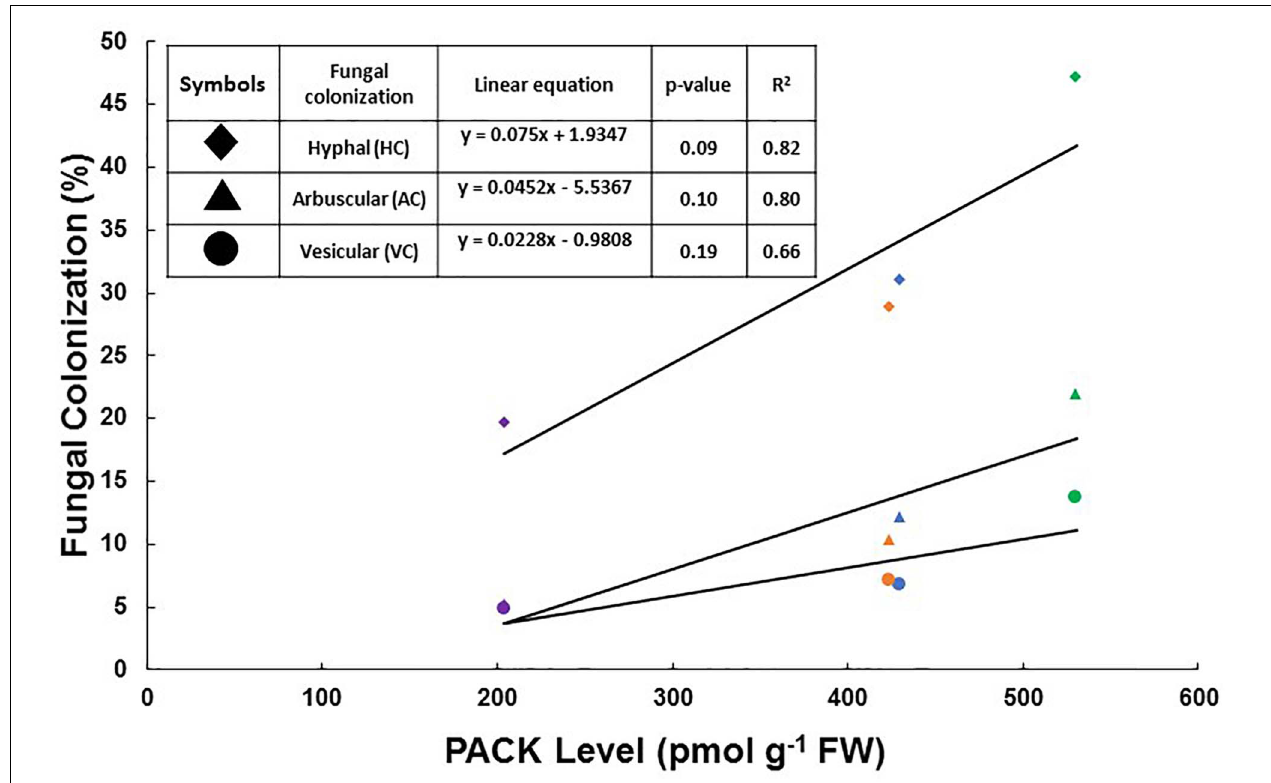
FIGURE 7 | Effect on fungal colonization (%) of the levels of putatively active CK (PACK; sum of riboside and free base fractions) measured in shoots of plants, the crowns of which had been subjected to treatments with synthetic CK status-modifying compounds. Each data-point corresponds to the mean of the fungal colonization assessed in the R. irregularis -inoculated plants. The symbols in purple represent the colonization seen in E151 roots treated with PI-55; those in orange represent the colonization seen in non-treated E151 roots. The symbols in blue represent the colonization assessed in non-treated WT roots, and those in green the colonization seen in WT roots treated with INCYDE. This graph is a composite graph created to decipher whether or not a relationship existed between AM fungal colonization and shoot levels of PACK. Whereas the PACK analysis was performed at 13 DAI, the assessment of fungal colonization was done at 28 DAI for WT and at 35 DAI for E151. A linear regression analysis was performed on the distribution of PACK and HC, AC, and VC; the resulting p -values and R 2 values are shown in a table, along with the linear equation for each fungal